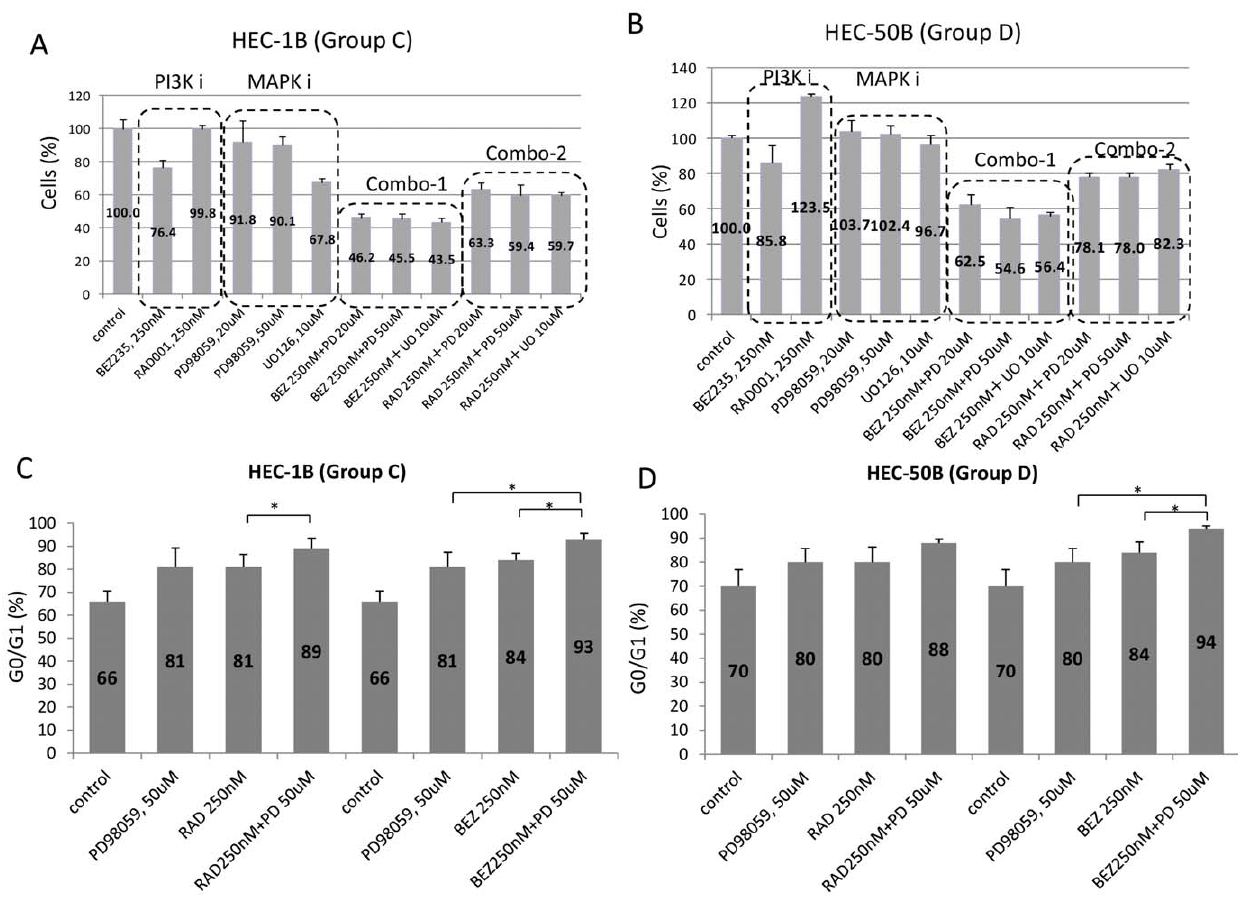
Figure 6. Inhibition of cell proliferation and augmentation of G1 arrest by combination of a MEK inhibitor and NVP-BEZ235 (or RAD001) in cells with alterations in K-Ras (mutation or amplification). (A)–(B) WST-8 assay was performed in HEC-1B (group C) and HEC-50B (group D) cell lines. All the experiments were repeated three times and each value is shown as the mean of three experiments + / 2 S.D. The combination of a MEK inhibitor (PD98059 or UO126) and NVP-BEZ235 (or RAD001) significantly augmented anti-proliferative effect in these cell lines, compared with either inhibition alone (p , 0.05 by Student’s t-test). (C)–(D) Flowcytometric analysis of cell cycle in HEC-1B and HEC-50B cells. All experiments were repeated 3 times, and each value is shown as the mean of 3 experiments 6 S.D. Combination of a MEK inhibitor (PD98059 or UO126) and NVP-BEZ235 significantly augmented the percentage of cells in the G0-G1phase of the cell cycle in these cells. *: p , 0.05 by Student’s t-